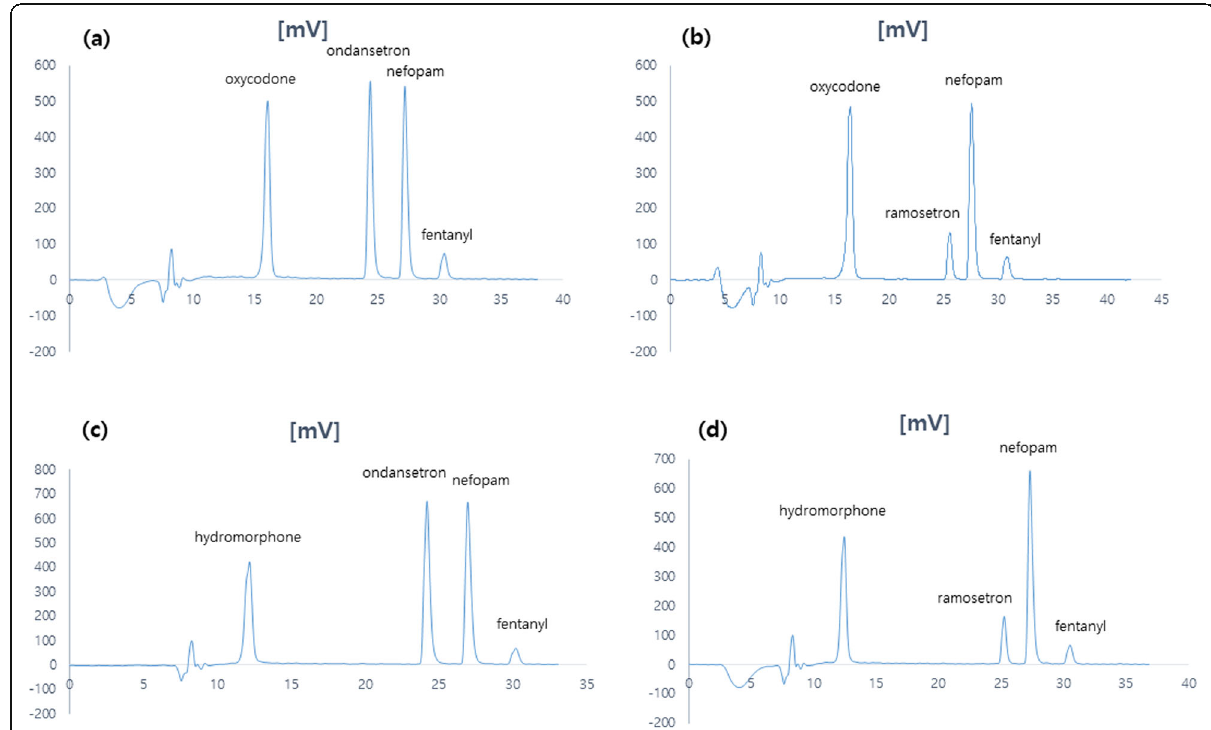
Fig. 1 Chromatograms from samples taken immediately after preparation of the B mixtures. a Mixture 1B. b Mixture 2B. c Mixture 3B. d Mixture